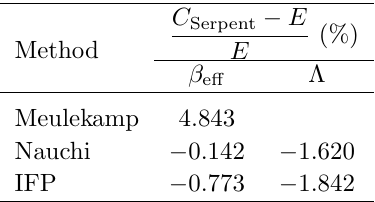
Table 15. Relative difference in Serpent-evaluated Godiva kinetics